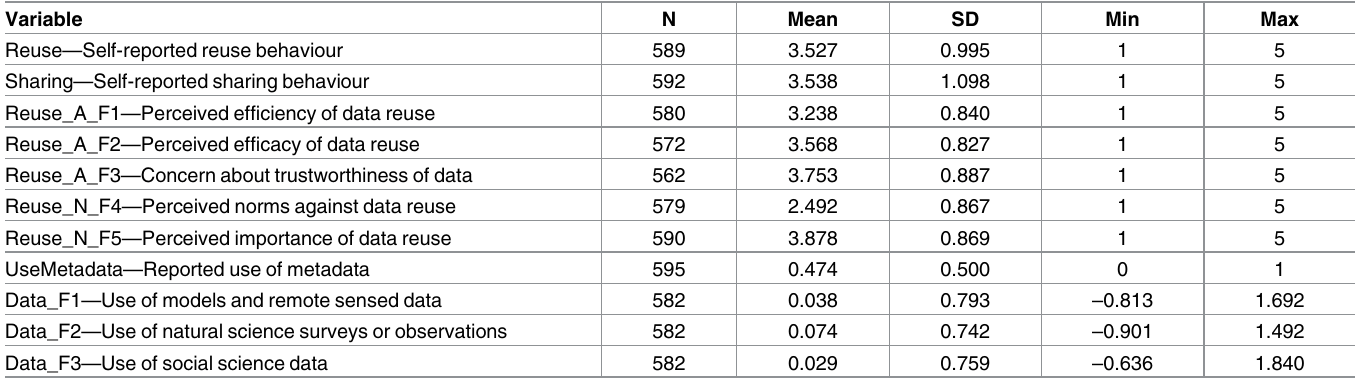
Table 4. Descriptivestatistics for variables.